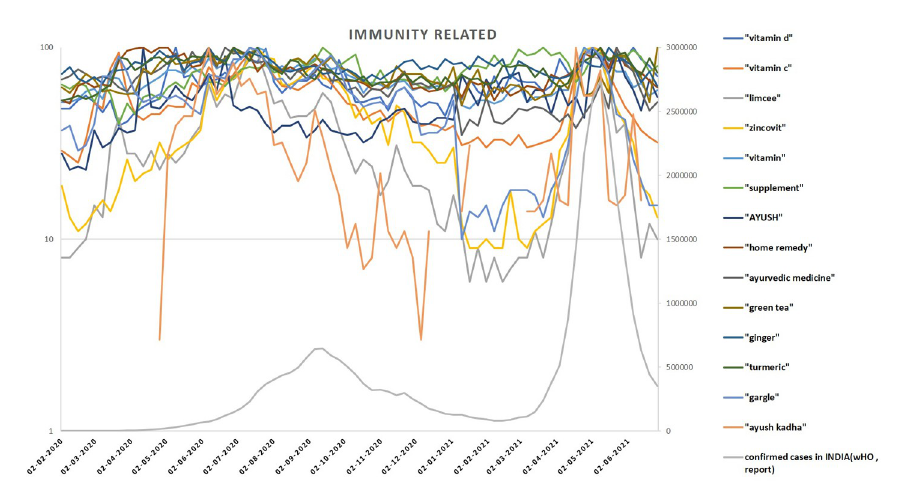
Fig 1. A positive correlation was observed between the number of COVID cases and search terms like “vitamin D”, “Limcee”, “grocery delivery”, “vegetable sanitizers”, “alcohol” etc. whereas, search terms like “street food”, “junk food”, “food delivery” etc. were negatively correlated to the number of cases.